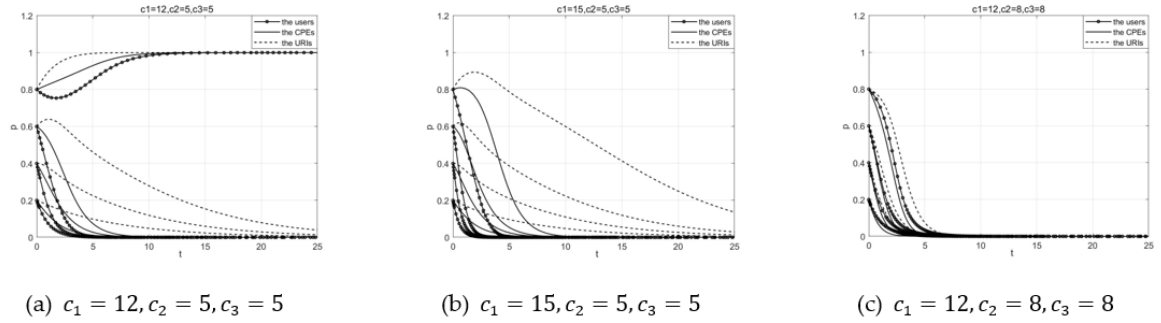
Figure 6. Impact of technological innovation investment on the strategies of the Users, the CPEs and the URI, and ( a – c ) show the evolution of the tripartite strategies under different values of 𝑐 (cid:2869) , 𝑐 (cid:2870) , 𝑐 (cid:2871) .